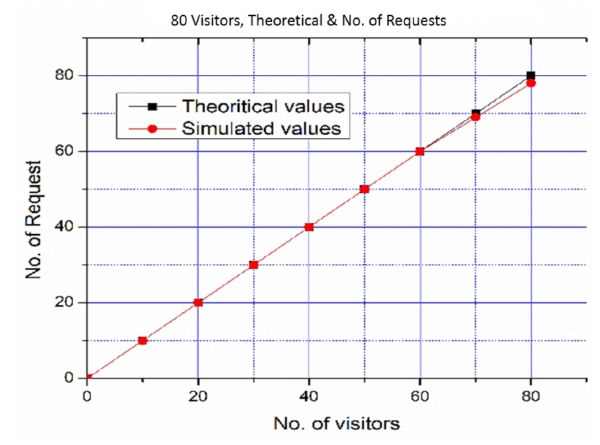
Figure 19. SNIS Performance with 480 Objects and 80